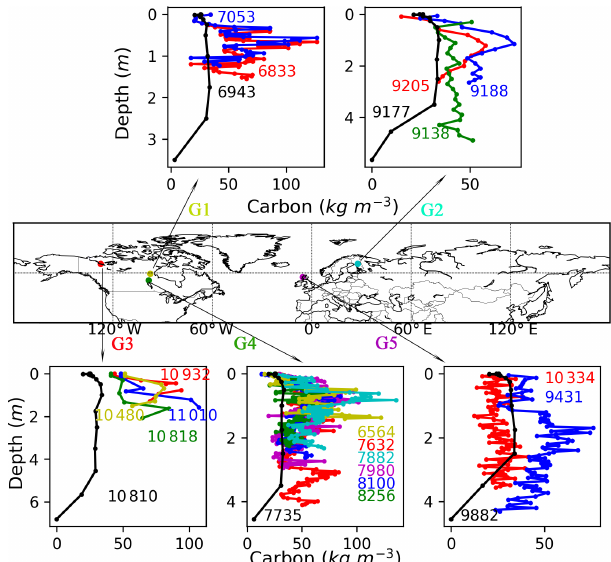
Figure 4. Observed (coloured, with each coloured line representing one peat core) and simulated (black) vertical C profiles of five grid cells where there is more than one core. The numbers in the figure indicate ages of sampled peat cores (coloured) and time length of the simulation (black is the mean age of all cores in the same grid cell).